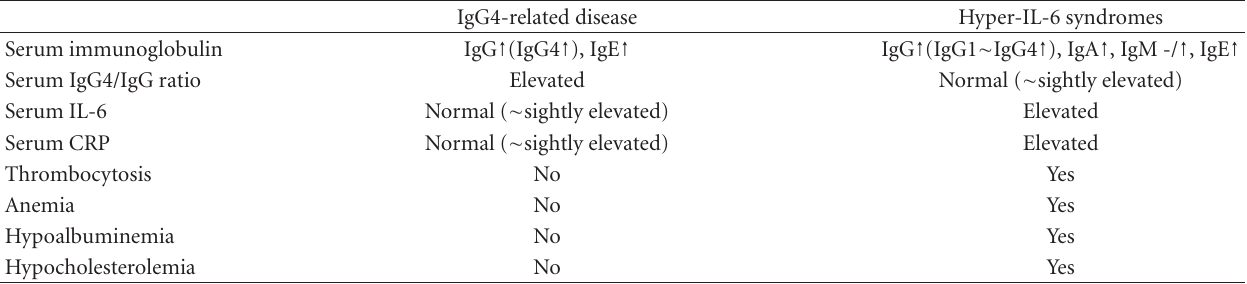
Table 2: Distinction between IgG4-related disease and hyper-IL-6